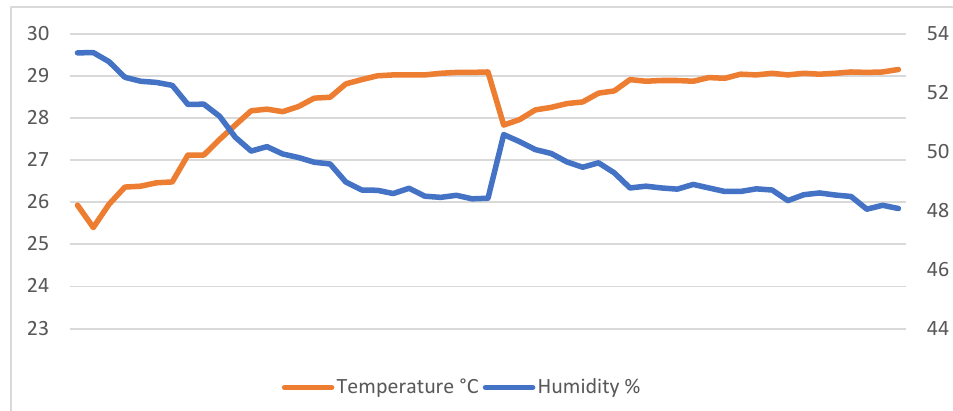
Figure 12. Ambient conditions. Table 6. Reported data from ambient conditions .